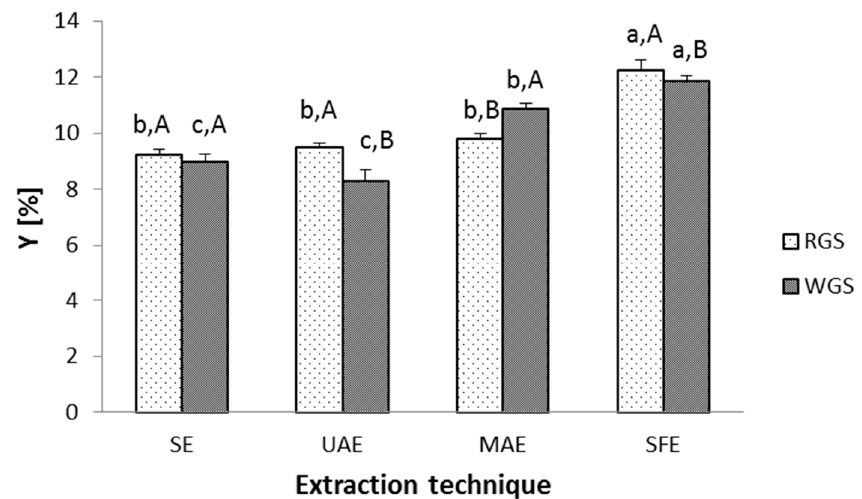
Figure 2. Total extraction yield for grape seed oils recovered by conventional and modern extraction techniques. * Different lowercase letters indicate significant difference ( p ≤ 0.05) between extraction techniques, while different uppercase letters indicate significant difference between red grape seeds (RGS) and white grape seeds (WGS).